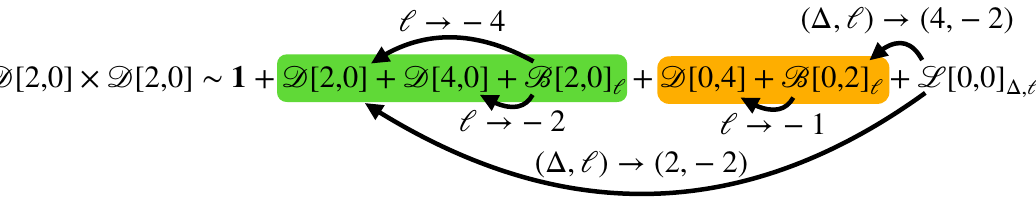
Figure 1. The self-OPE of the stress tensor multiplet. See the main text for further